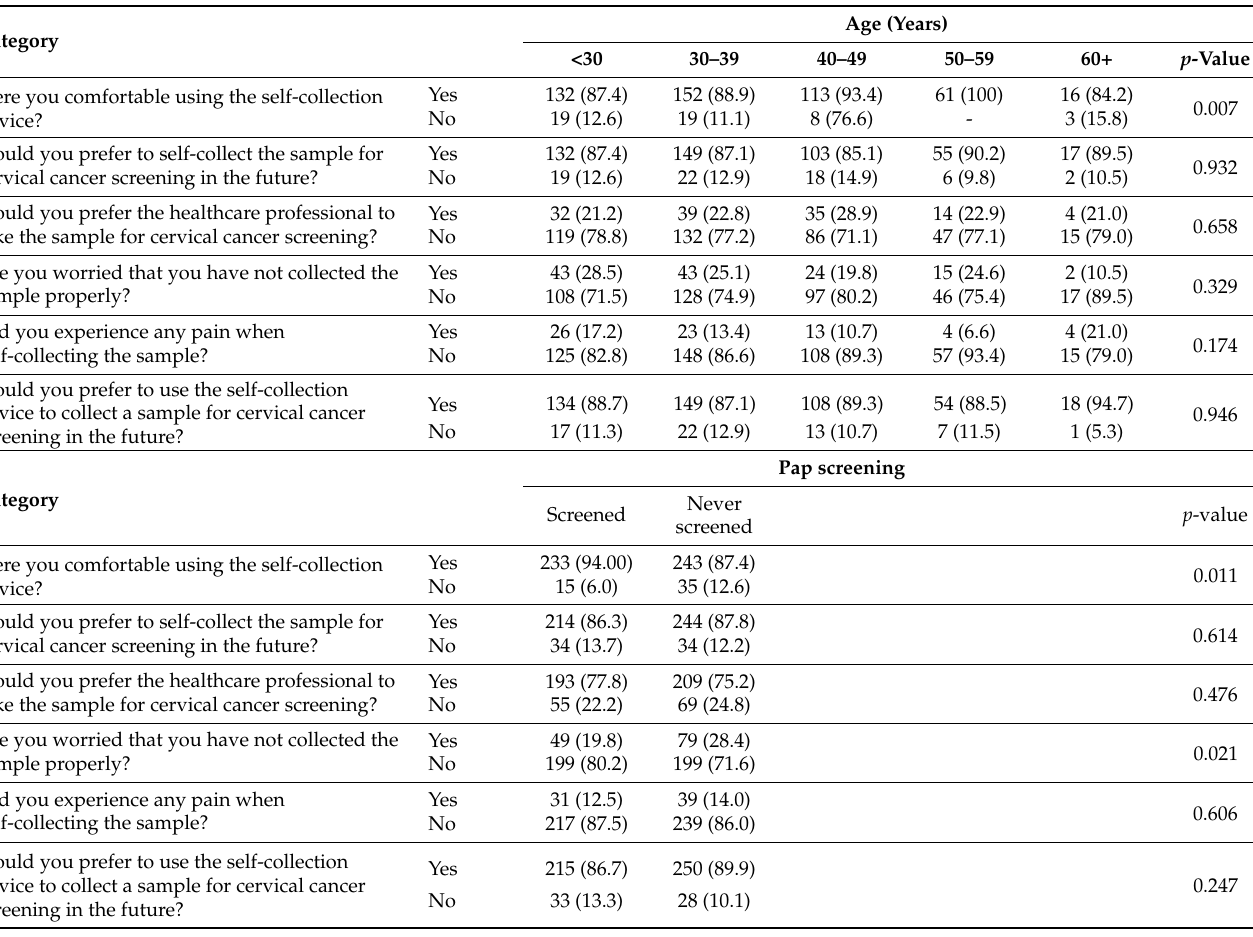
Table 5. Experience and preferences of self-sampling by age group and